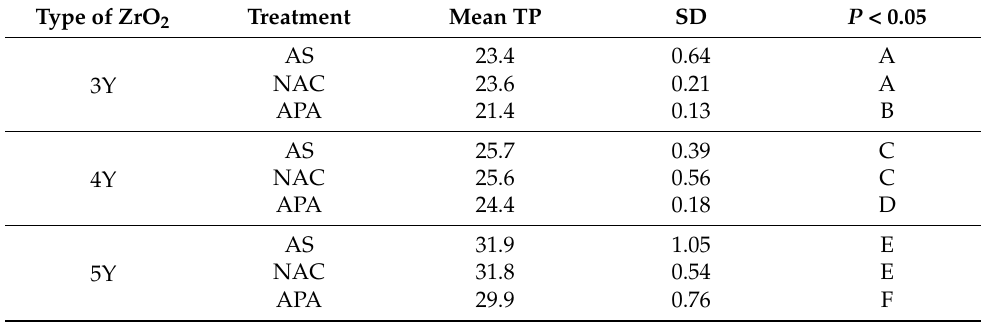
Figure 6. The translucency of zirconia ceramics (3Y, 4Y, 5Y) in 1 mm thickness.